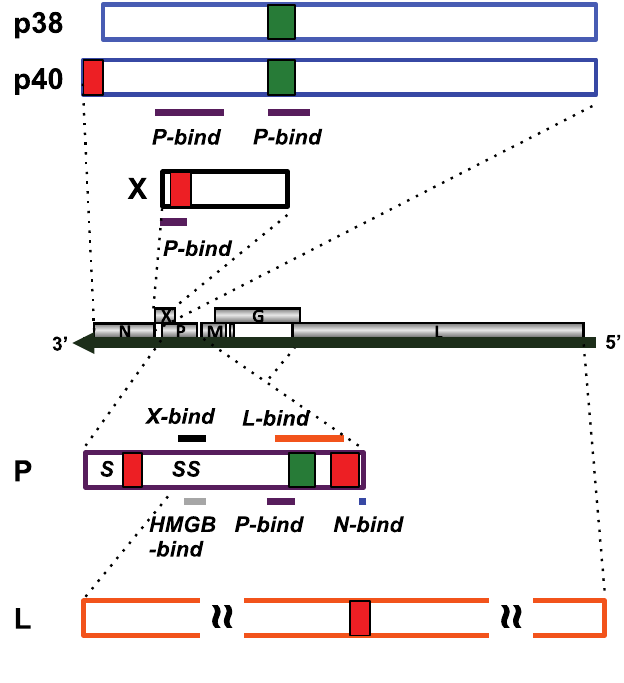
Figure 1. Map of nuclear transport signals in the BDV proteins and sites of interaction with other proteins. The red boxes indicate NLSs and the green boxes indicate NESs. “S” in P indicates the site of